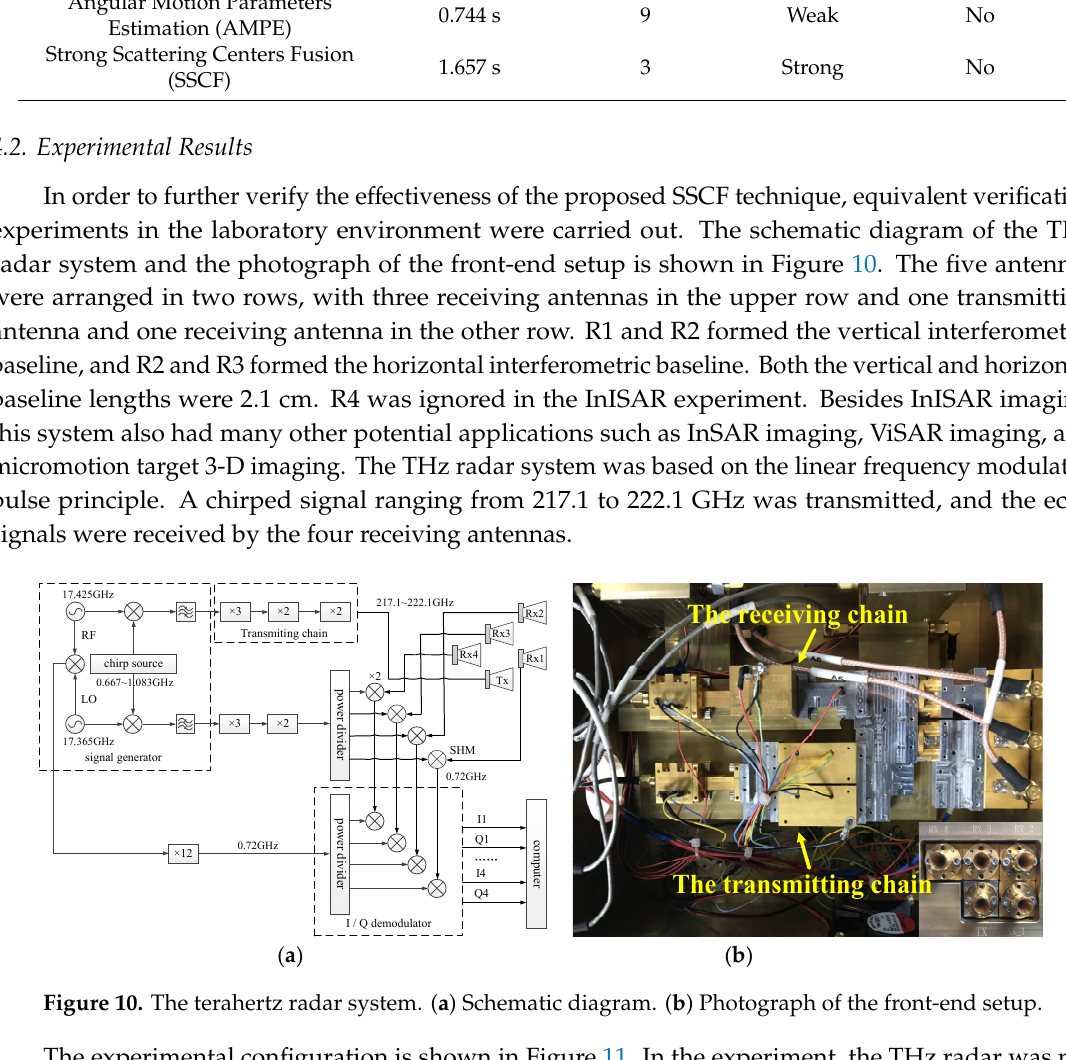
Table 2. Comparison of algorithm performances.